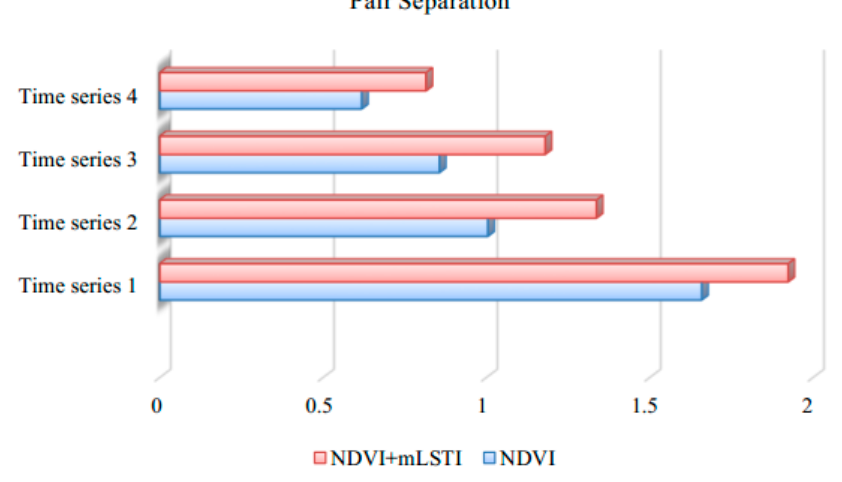
Figure 8. Separation of sorghum and soybeans.